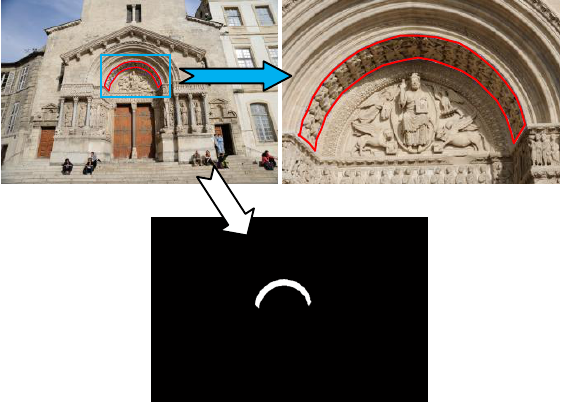
Figure 7: Drawn area (up) and extracted mask (down) 5.2 Research of the 3D coordinates of the area As the white area in the mask represents the annotation on the image, the position (row and column) of pixels of this area must be known in order to extract the corresponding X, Y and Z coordinates. In this way, all positions of white pixels of the mask are searched and a list of couples of values i (row) and j (column) is constructed. Knowing the concerned positions, the list of corresponding X, Y and Z triplets is given by the reading of X, Y and Z coordinates at these positions in the XYZ file of the image (Figure 8).